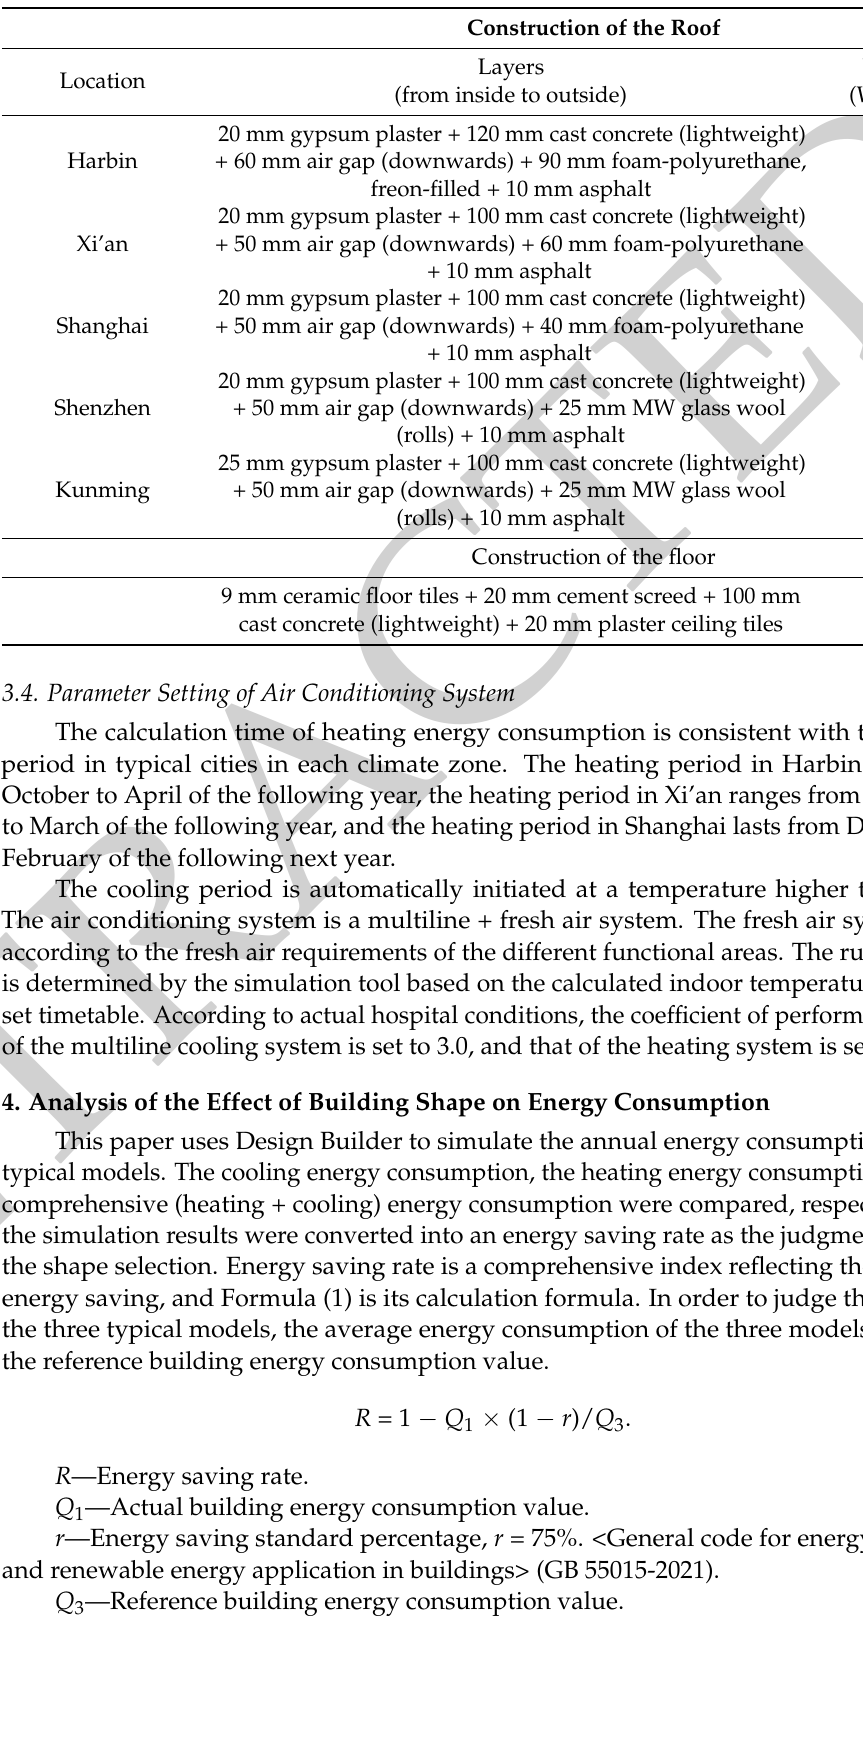
Table 7. The floor and roof parameter setting in the five climate